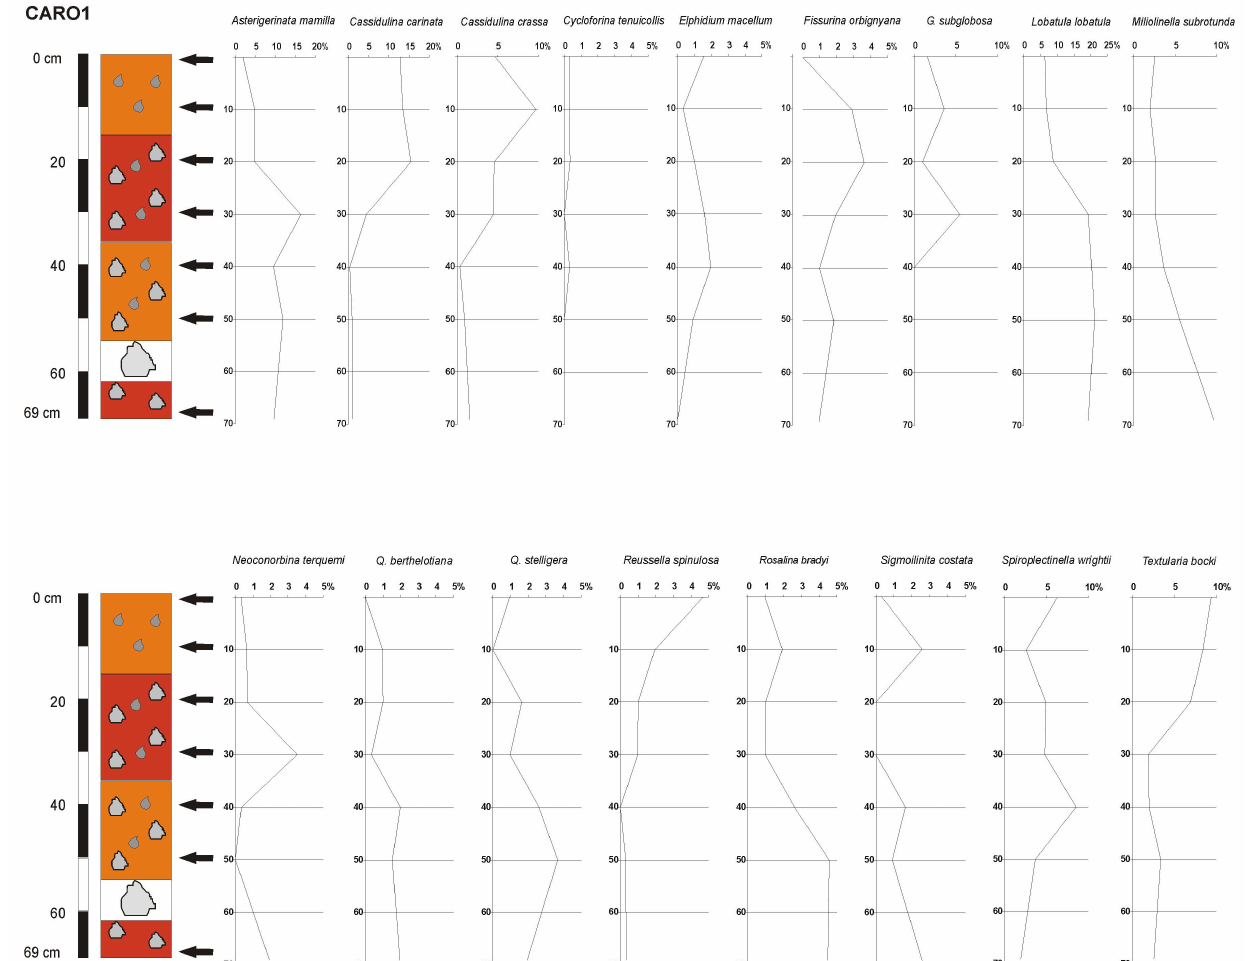
Figure 5. Relative abundance along the core Caro1 of 17 benthic foraminiferal species utilized for statistical